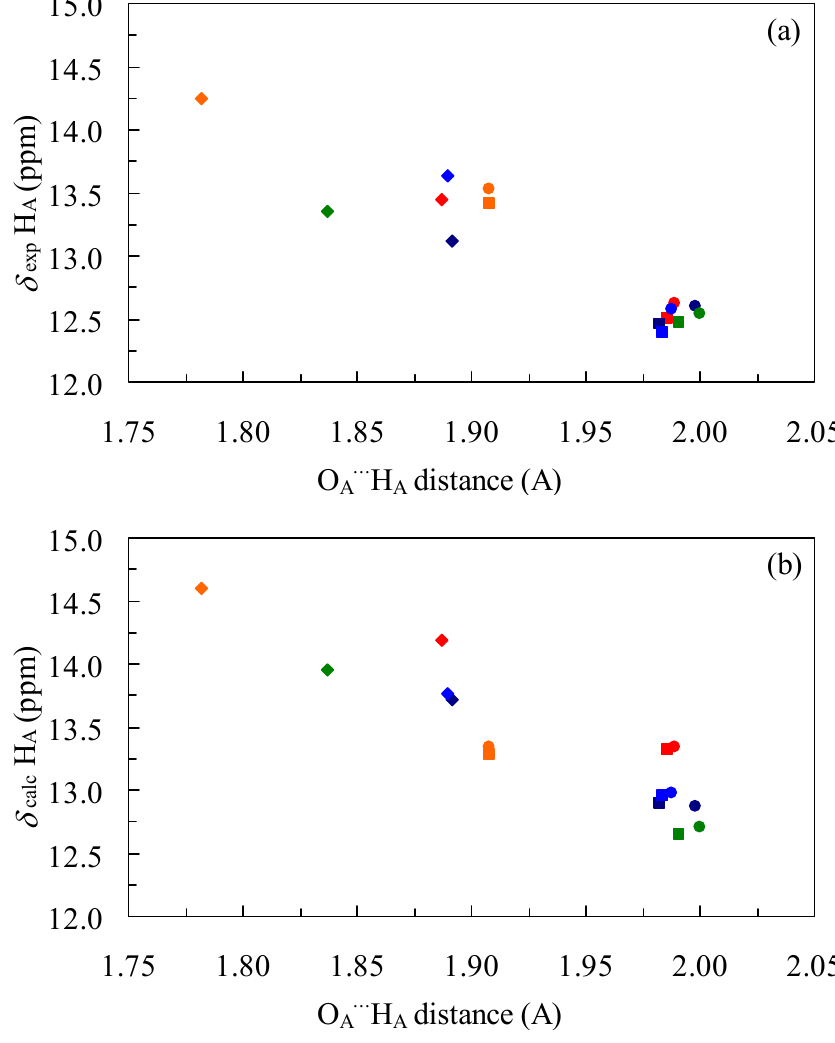
Fig. 9 Plots of experimental (a) and calculated (b) 1 H-NMR chemical shift of H A vs. the O(4) ... H A internuclear